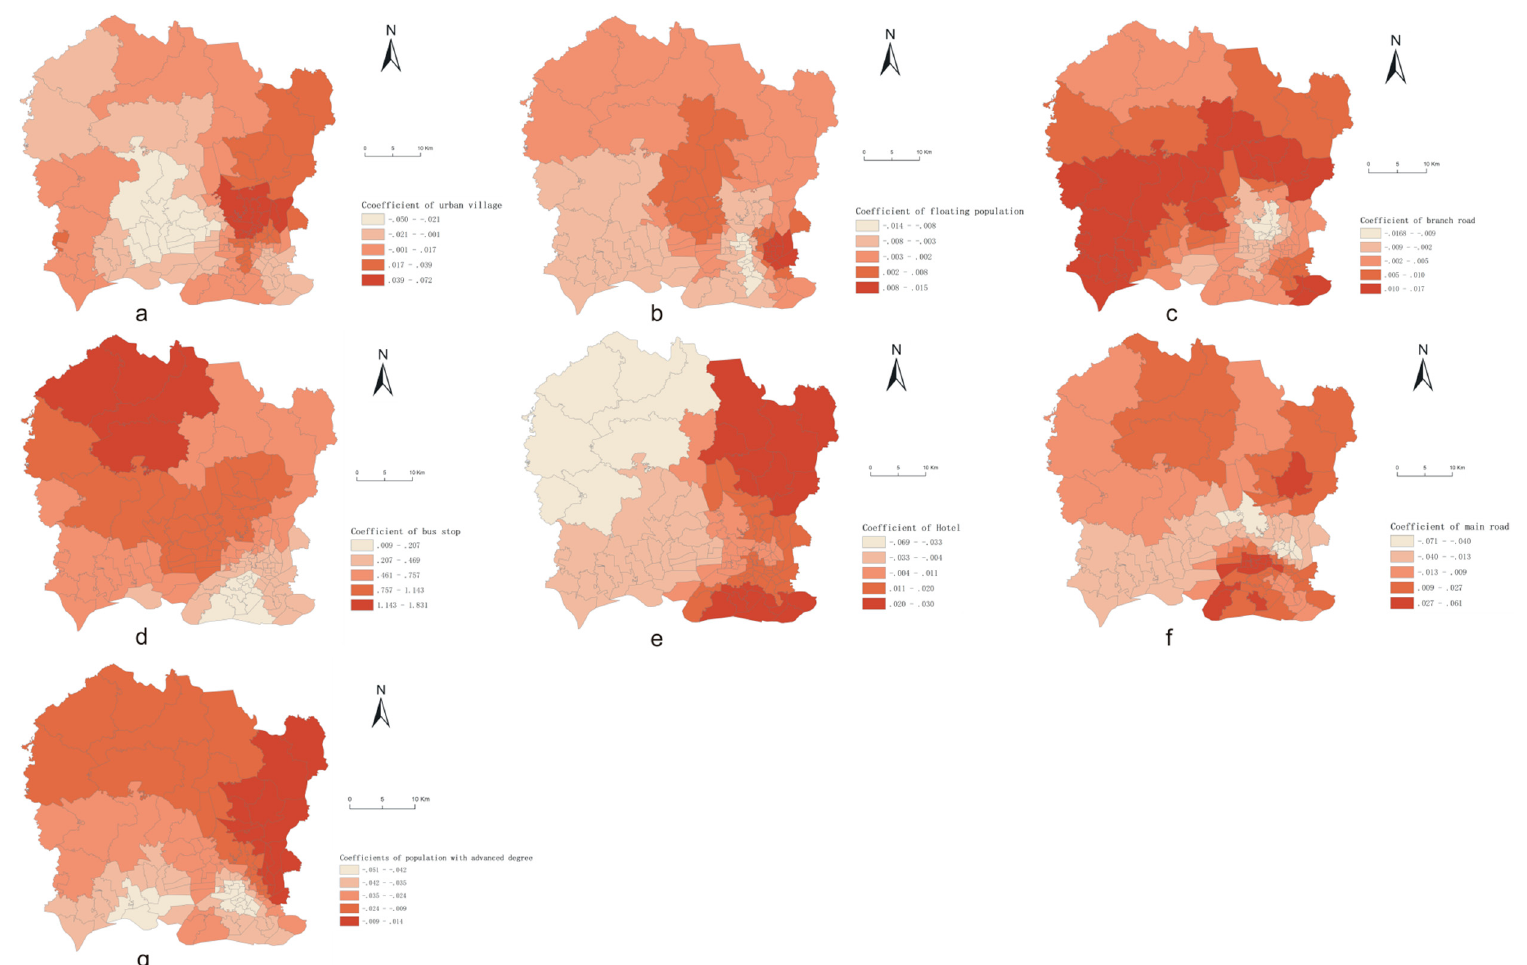
Figure 4. Spatial distribution for local coefficients of explanatory variables.